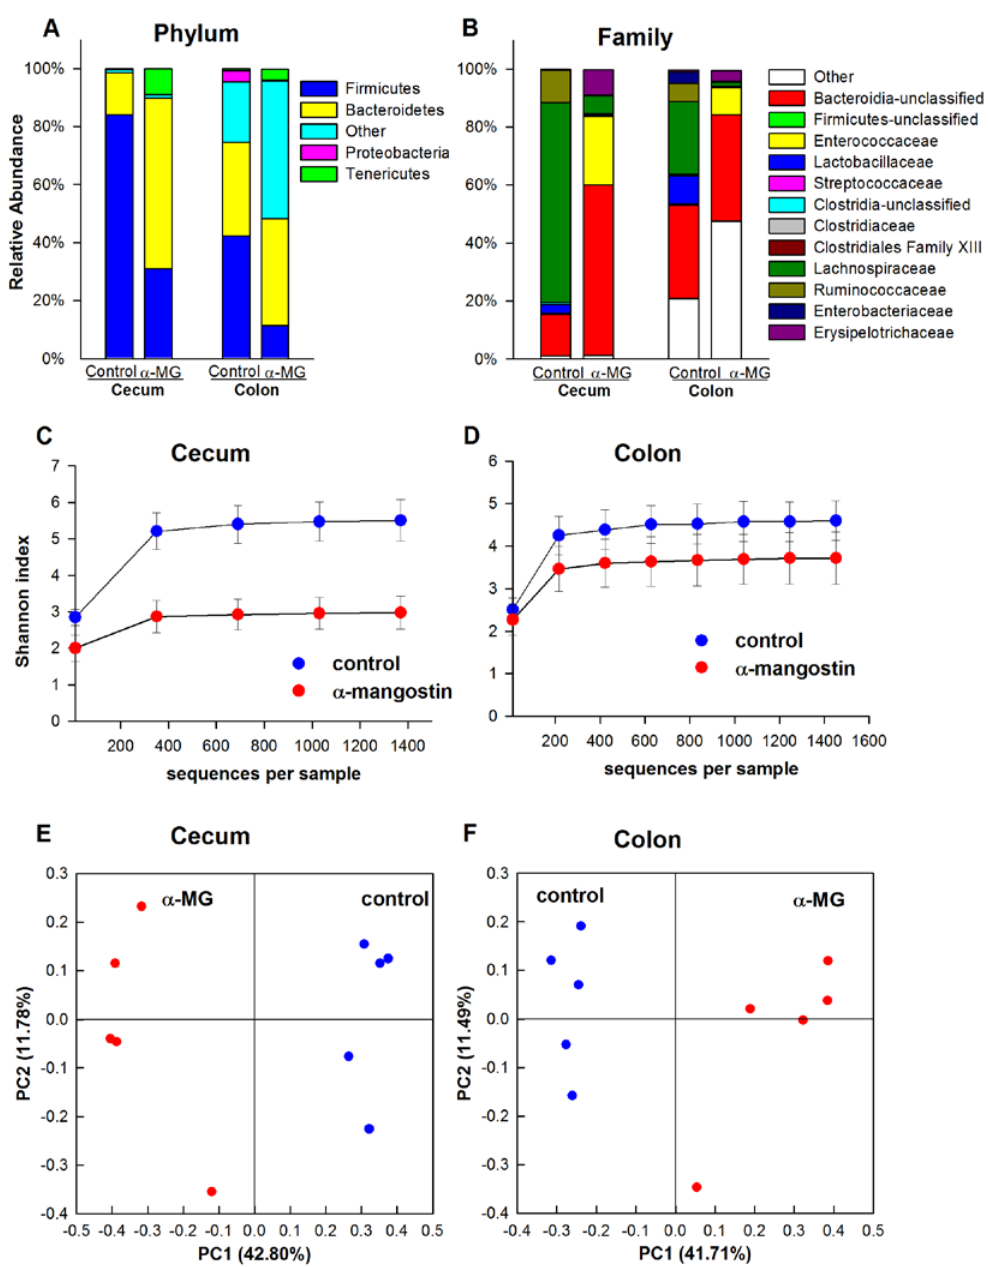
Figure 4. Dietary α-MG alters gut microbiota in Balb/c mice. Dietary α-mangostin (α-MG) changes the relative abundance of bacterial communities in the cecum and colon of Balb/c mice at the ( A ) phylum and ( B ) family levels. Significantly lower α-diversity in ( C ) cecum and ( D ) colon of mice fed α-MG. Panels E and F show principal coordinate analysis (PCoA) for cecum and colon, respectively. Samples in the α-MG group (red) are well separated from those in control group (blue). Data are for tissues from 5